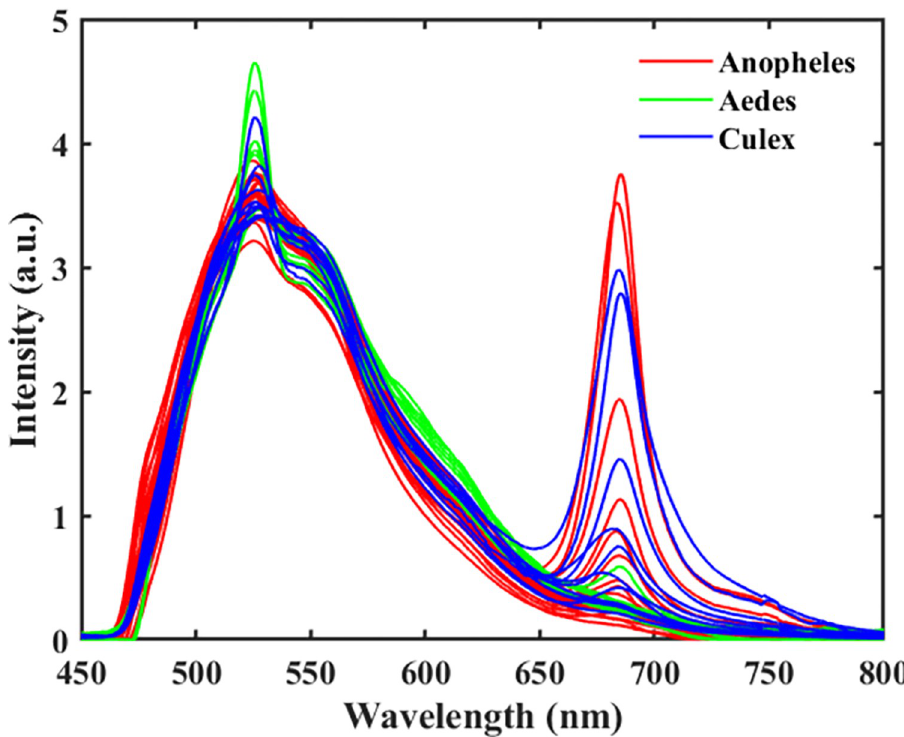
Fig 3. LIF spectra of water samples collected from three different breeding sites of mosquito species ( Anopheles , Aedes , and Culex ) in Cape Coast,